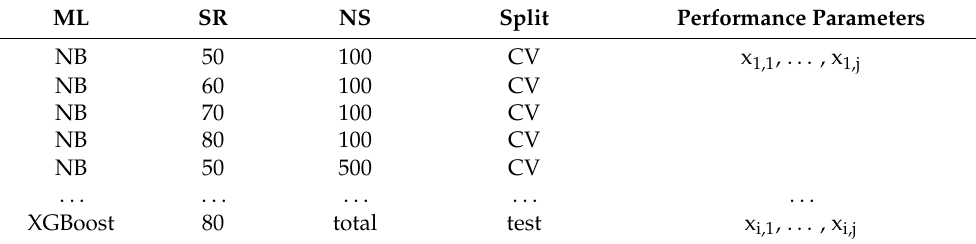
Table 1. The structure of the summarized results of modeling. (ML: Machine learning algorithms, SR: train/test split ratio, expressed as the percentage of compounds assigned to the training set, NS: number of samples, NB: naïve Bayes, CV: